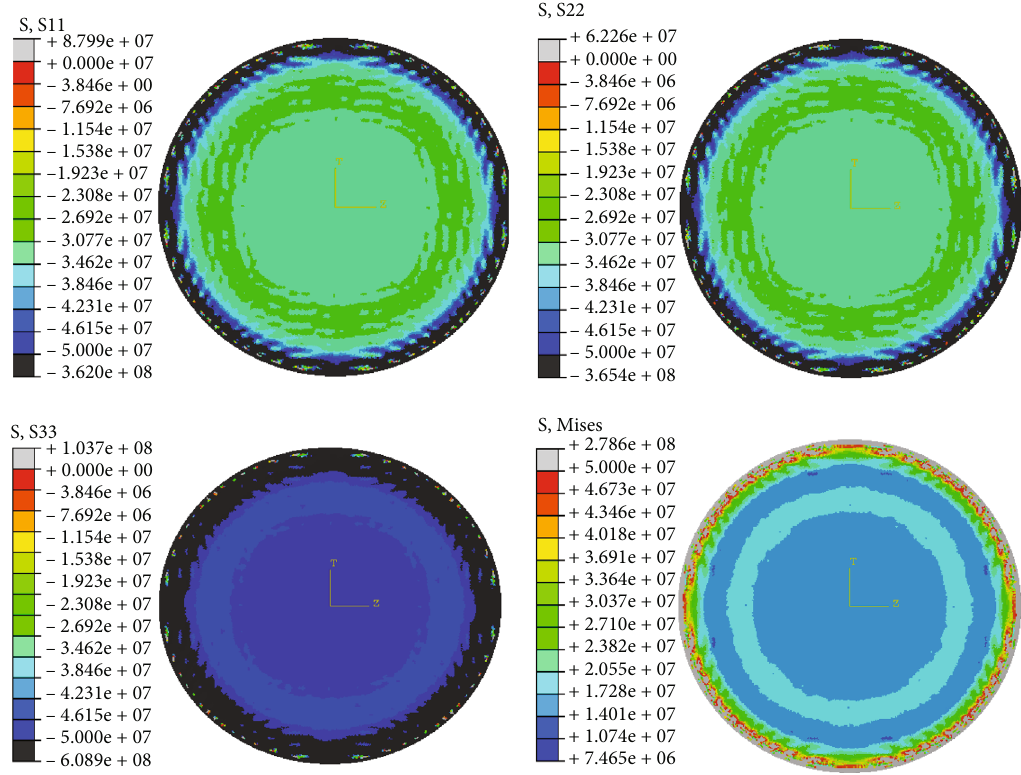
Figure 16: Displacement stress cloud images of proppant